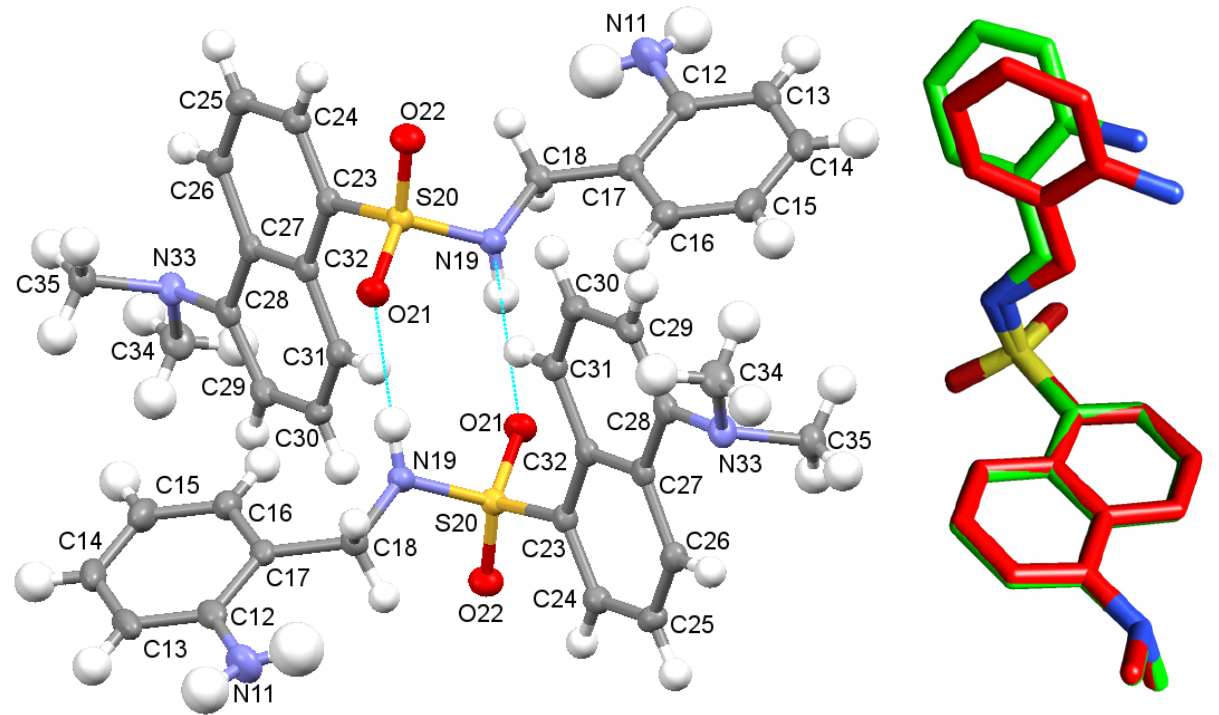
Figure 2. ( Left ): Ellipsoid diagram of the molecular structure found for DsA, including its labelling scheme. Two neighboring molecules are showing their mutual interaction. ( Right ): Superimposition of the stick diagrams of the experimental structure and the calculated one (M062X/6-31G*) for a single unit of DsA.